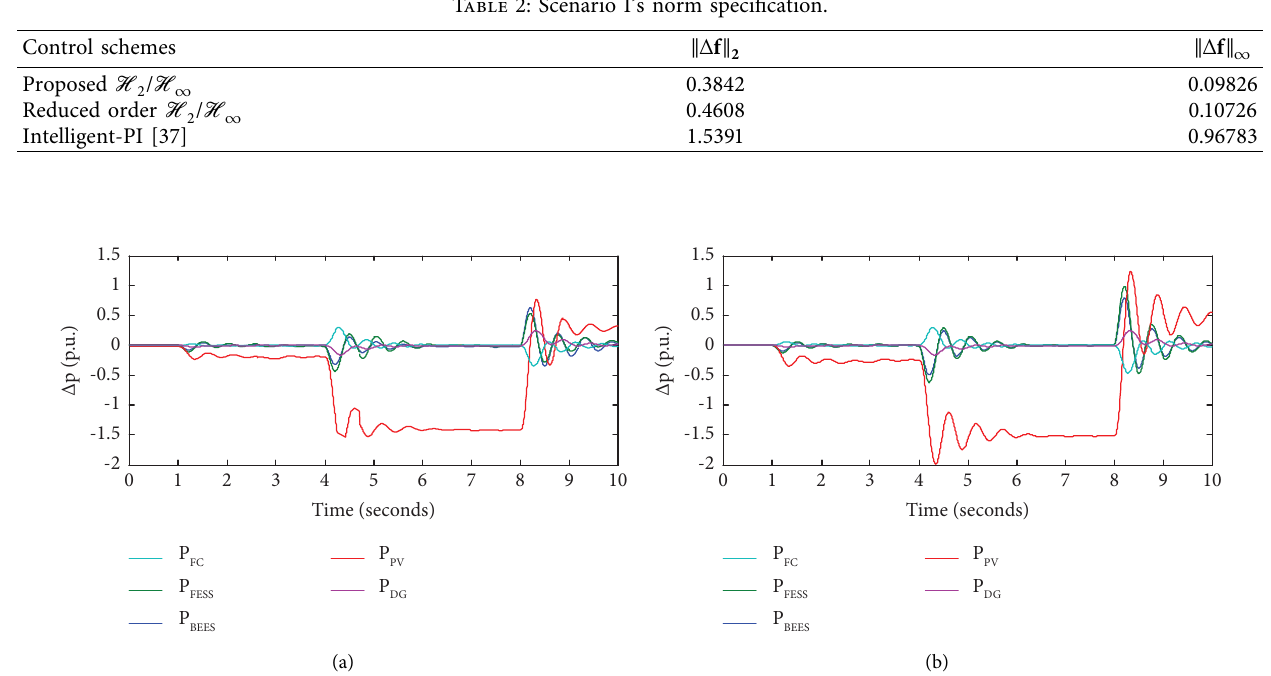
Figure 11: Power output of DG units: (a) output power of the units when the proposed control scheme is utilized and (b) output power of the units when the optimal PI presented in [37] is